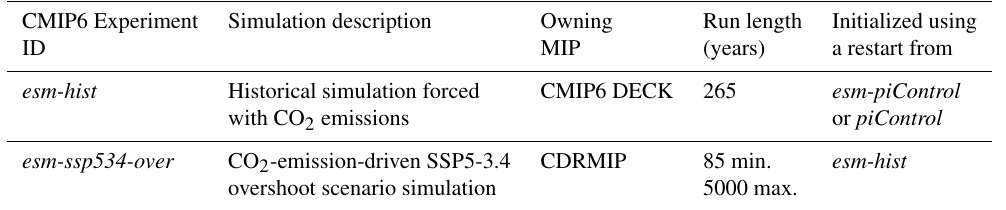
Table 5. Emission-driven SSP5-3.5-OS scenario experiment ( CDR-overshoot ) simulations. All simulations are required to complete the experiment.